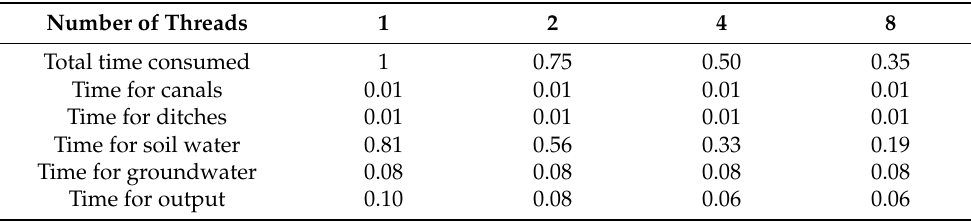
Table 5. Relative calculating time consumed with different numbers of threads (all the computing times are relative to the total computing time with one thread).